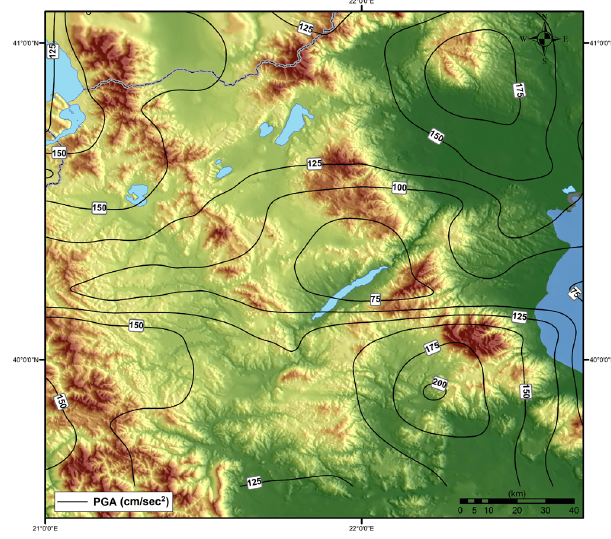
Fig. 4. Peak ground acceleration (cms − 2 ) with probability 90% of not being exceeded in 50yr (Return Period = 475yr) for the period 1900–1994.